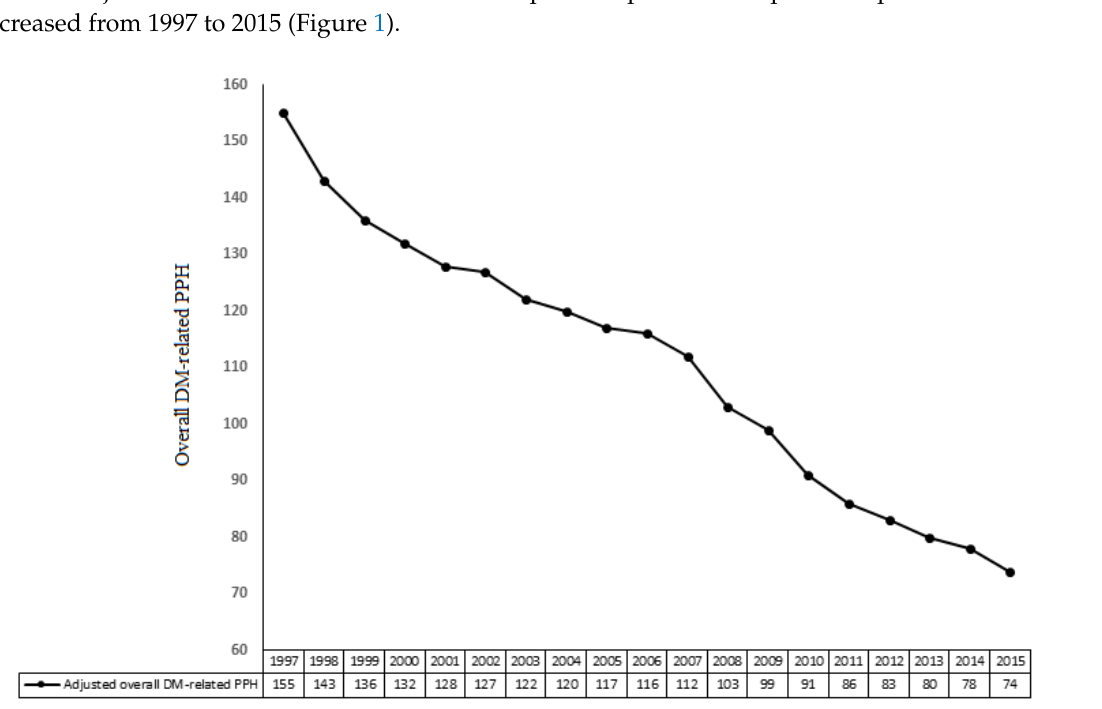
Figure 1. Adjusted number of overall diabetes-related potentially preventable hospitalizations from 1997 to 2015. Data were calculated per 1,000 hospitalized patients with diabetes mellitus per year. DM: diabetes mellitus; PPH: potentially preventable hospitalizations